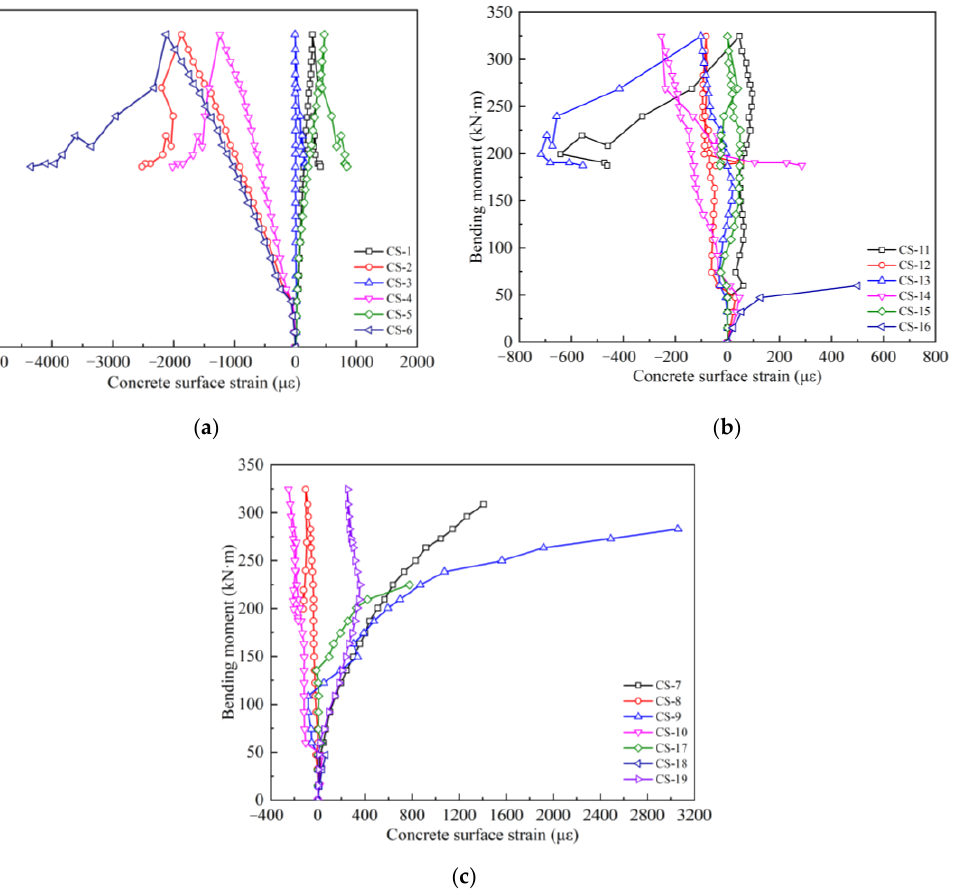
Figure 11. The bending moment–concrete strain relationship curves of 1/2 section: ( a ) monitoring points on top surface, ( b ) monitoring points on the bottom surface, ( c ) monitoring points on front and back